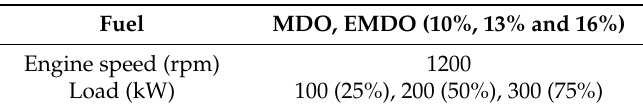
Table 4. Engine test